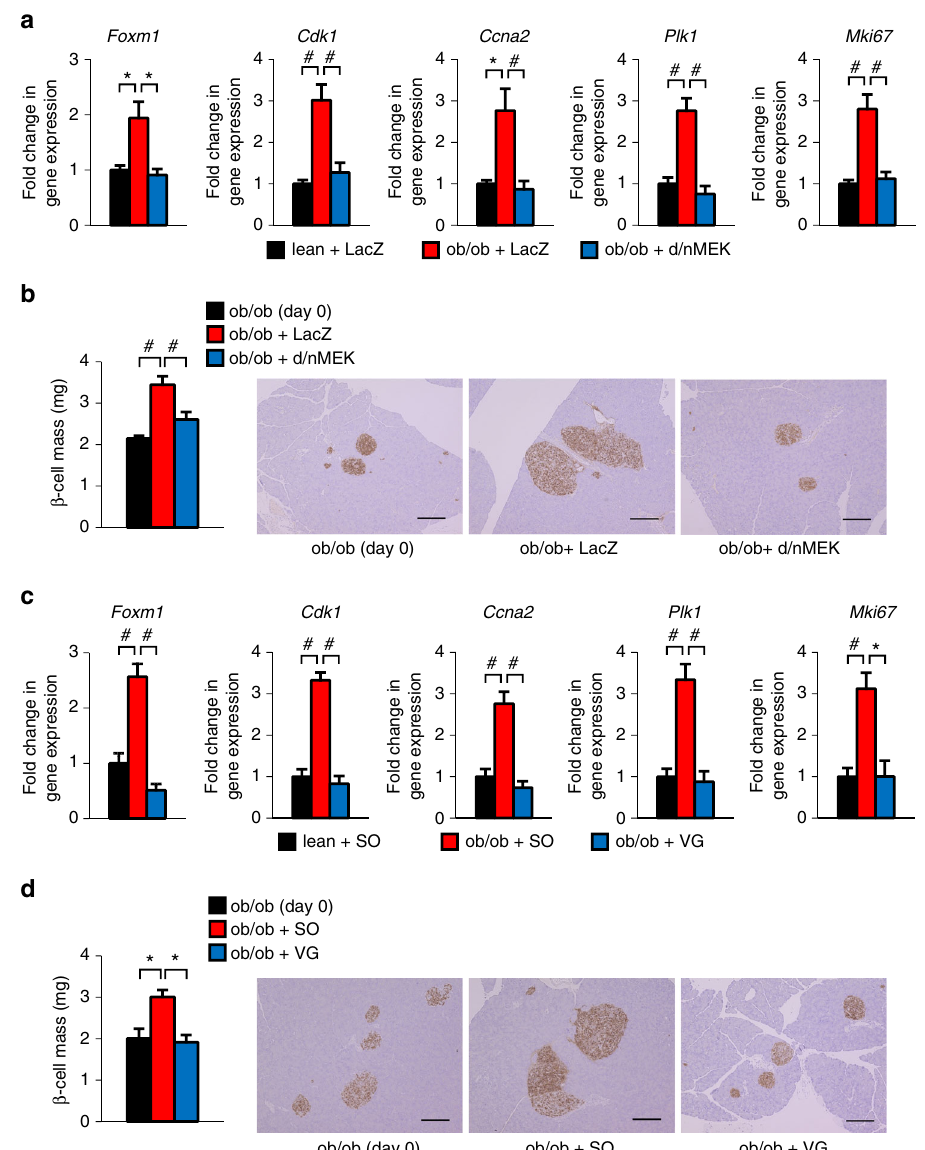
Fig. 2 Pancreatic vagal nerves upregulate the expression levels of Foxm1 and its target genes as well as that of the Mki67 gene in islets, thereby enhancing β -cell proliferation during obesity development. a Expression levels of Foxm1 and its target genes as well as that of the Mki67 gene in islets of ob/ob mice on day 7 after d/nMEK or LacZ adenoviral administration. b β -Cell mass of 6-week-old ob/ob mice on day 7 after d/nMEK or LacZ adenoviral administration; representative images are shown in the right three panels. c Expression levels of Foxm1 and its target genes as well as that of the Mki67 gene in islets of ob/ob mice on day 7 after VG or SO. d β -Cell mass of ob/ob mice on day 7 after VG or SO; representative images are shown in the right three panels. Gene expression levels in islets of LacZ-injected- a or SO c lean mice served as controls. β -Cell mass of 5-week-old ob/ob mice before adenoviral administration b or operation d served as controls (ob/ob (day 0)). Scale bar, 200 µ m. Data are presented as means ± s.e.m. NS, not signi fi cant, * P < 0.05, # P < 0.01, assessed by one-way ANOVA. n = 4 a , n = 6 b , n = 4 or 6 c , n = 3 – 6